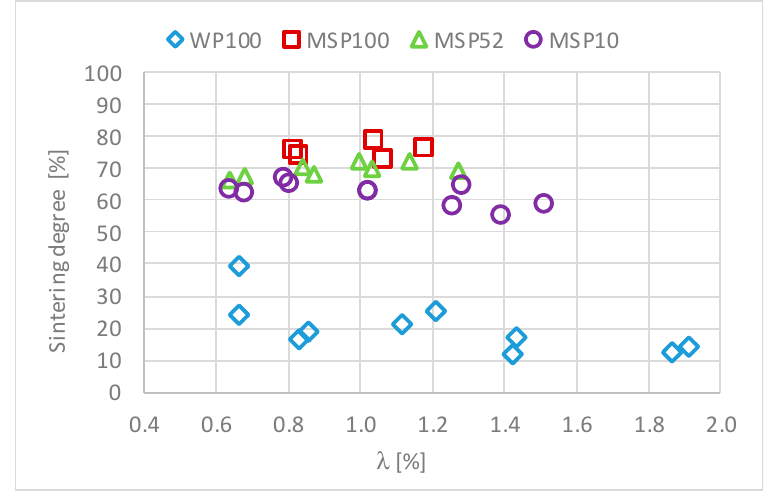
Figure 7. Sintering degree versus λ for the WP100 and MSP family.